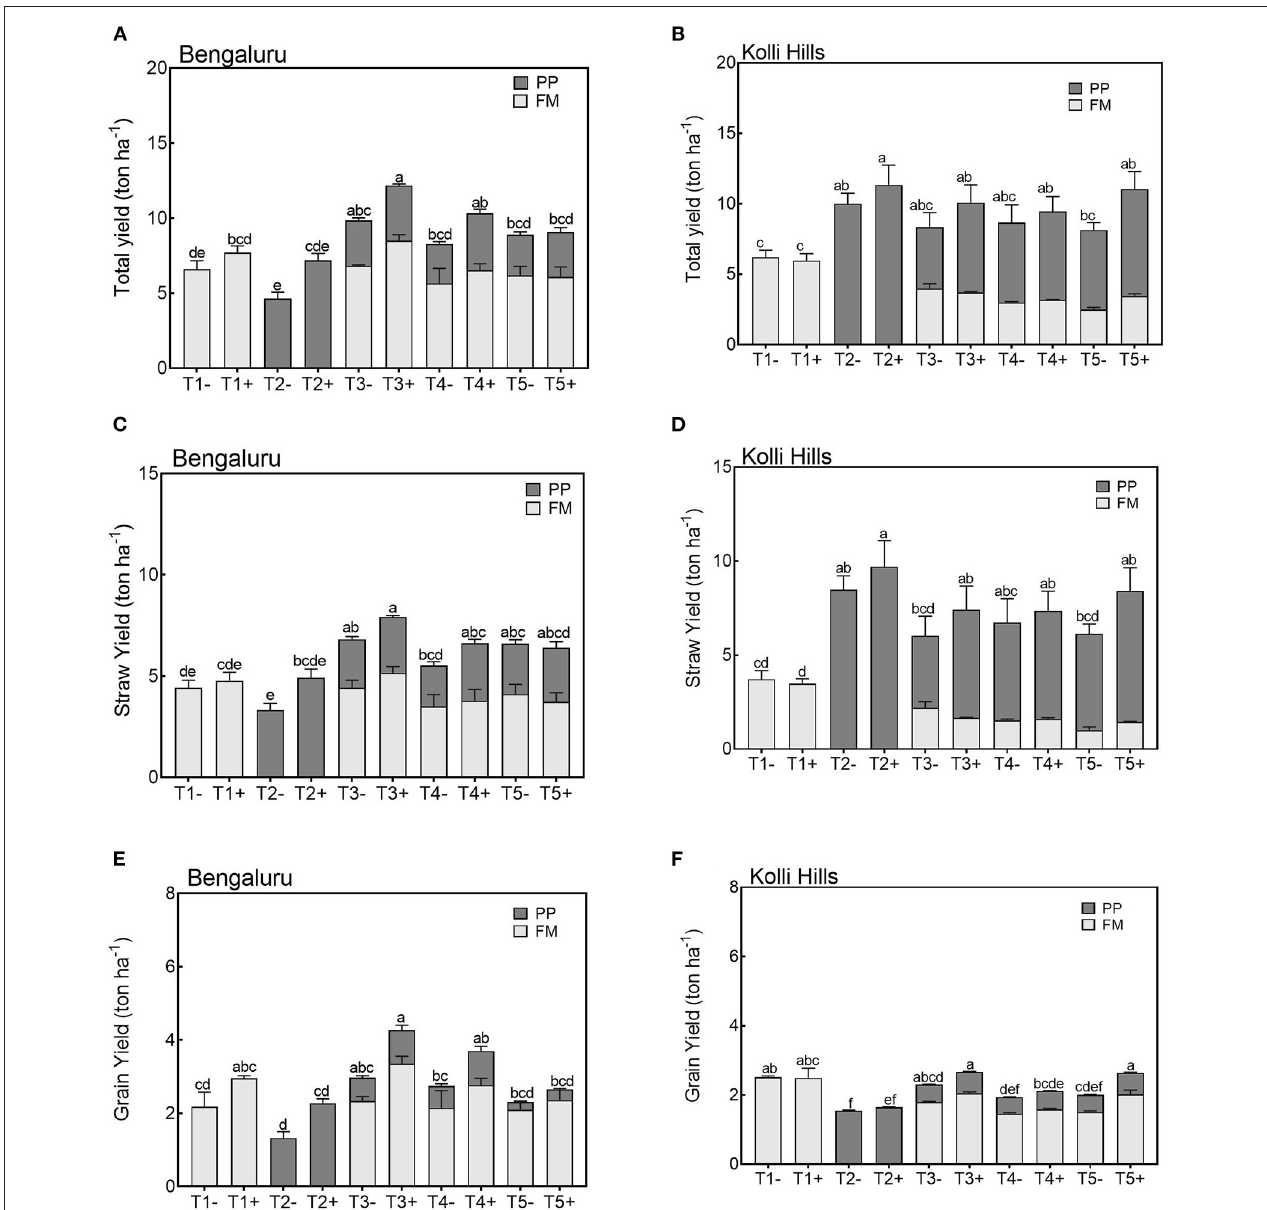
FIGURE 4 | Total biomass, straw and grain biomass at Bengaluru (A,C,E) and Kolli Hills (B,D,F) during year 2017/18. Bars represent the average of four replicates with standard error of mean. One-way ANOVA followed by Tukey‘s test ( post-hoc test) was used for the combined biomass of FM and PP, separately for each site, and values with same letters are not significantly different from each other at p >